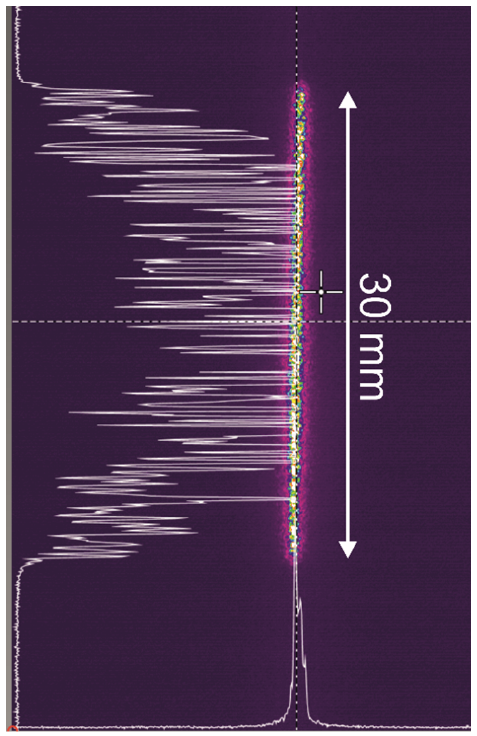
Figure 3. Beam profile of the laser sheet (30 mm high, 0.6 mm thick) used for laser-induced incandescence (LII) measurement.